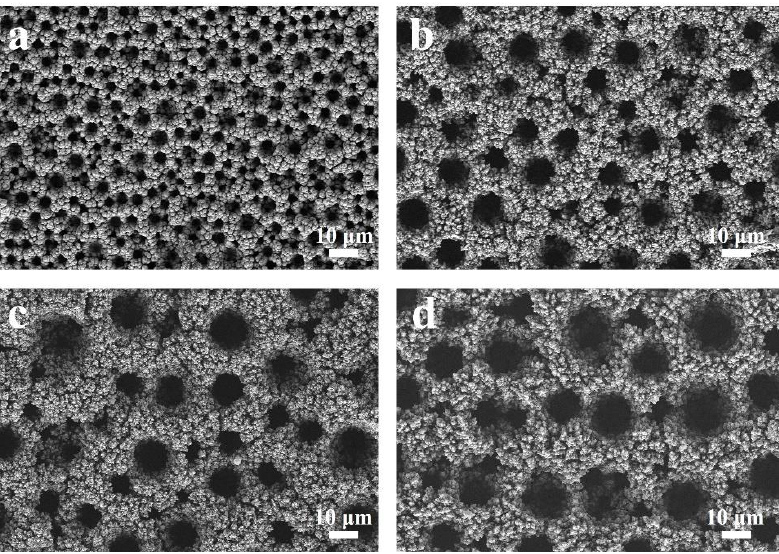
Figure 1. SEM images of prepared ( a ) Ni, ( b ) NiCo0.15, ( c ) NiCo0.3, and ( d ) NiCo0.45 microelec- trodes.